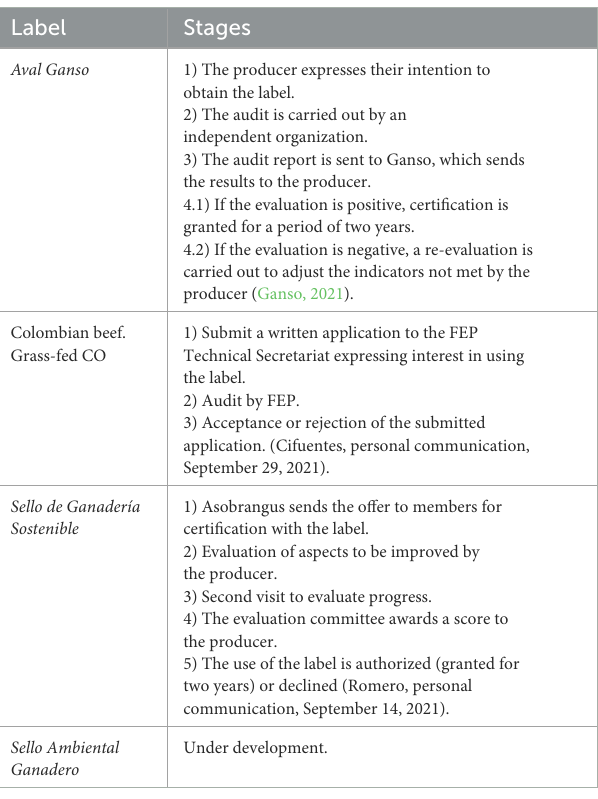
TABLE 6 Stages of the Colombian certification